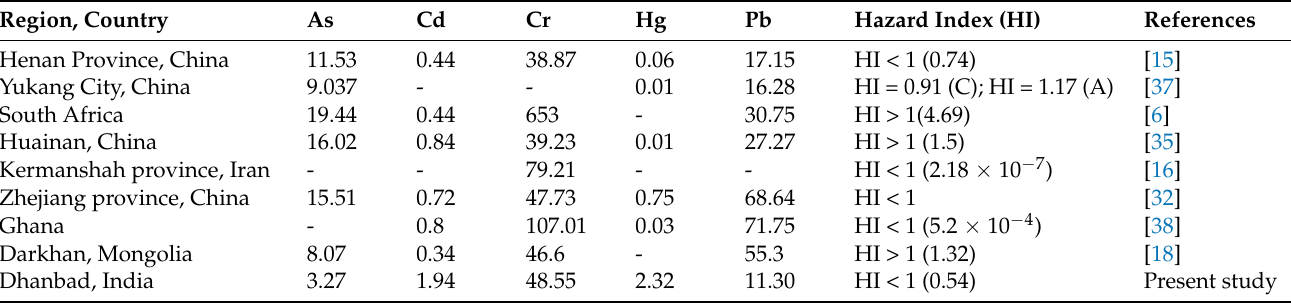
Table 6. Global potentially toxic metal(loid)s concentration (mg kg -1 ) in soil and associated health risk values in